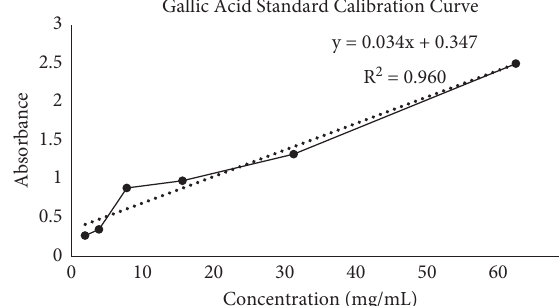
Figure 2: Standard calibration curve of gallic acid.